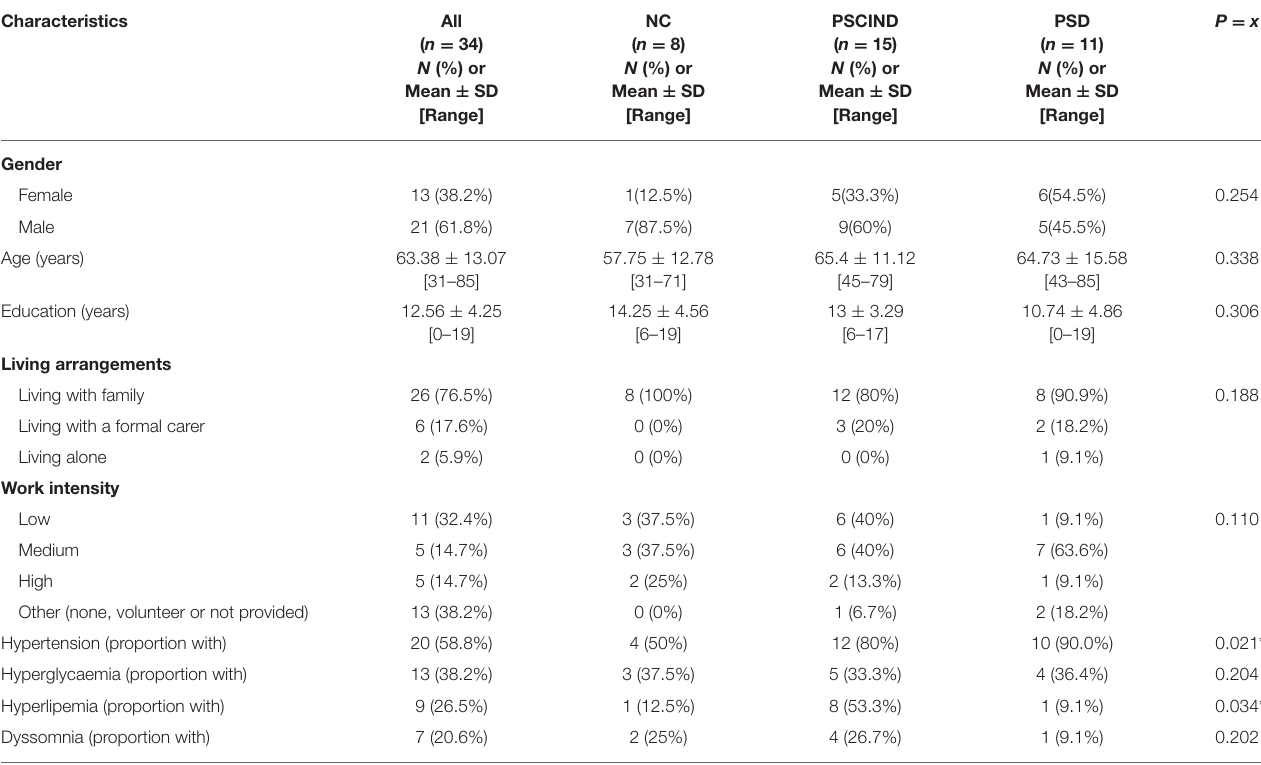
TABLE 1 | Characteristics of the participants included in total ( n = 34) and according to diagnosis classification. Characteristics